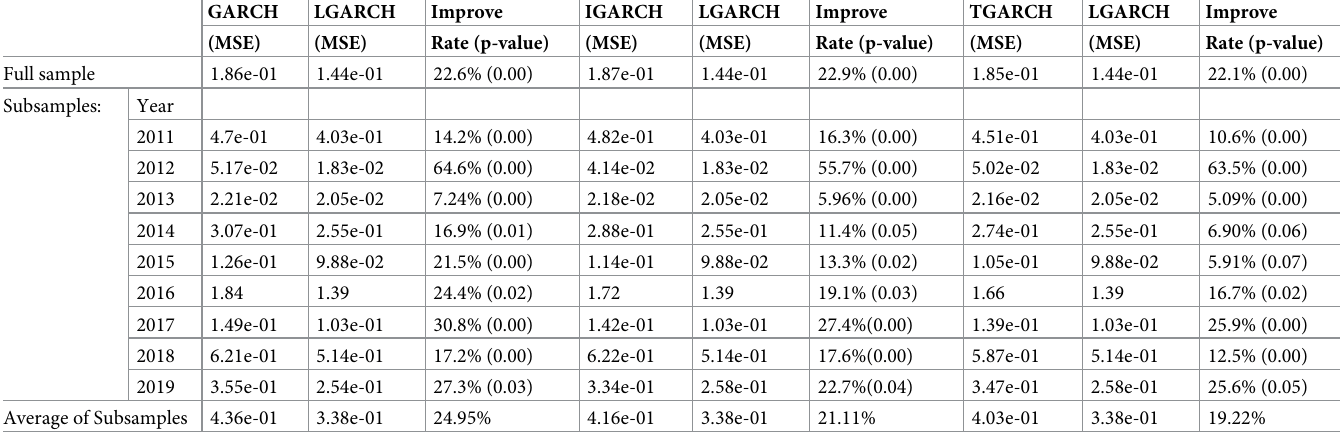
Table 5. Out of sample forecasting with simplified realized variance. This table presents the oil futures volatility out-of-sample forecasting results of Liquidity-adjusted GARCH (LGARCH) with other three GARCH models against the simplified realized variance using the Mean Squared Error (MSE). The p-values for statistical differences of the forecasting errors are also presented. The LGARCH model outweighs all other three models in both full sample and all subsample tests. Where en = � 10 n , e.g. e − 02 = � 10 − 2 .